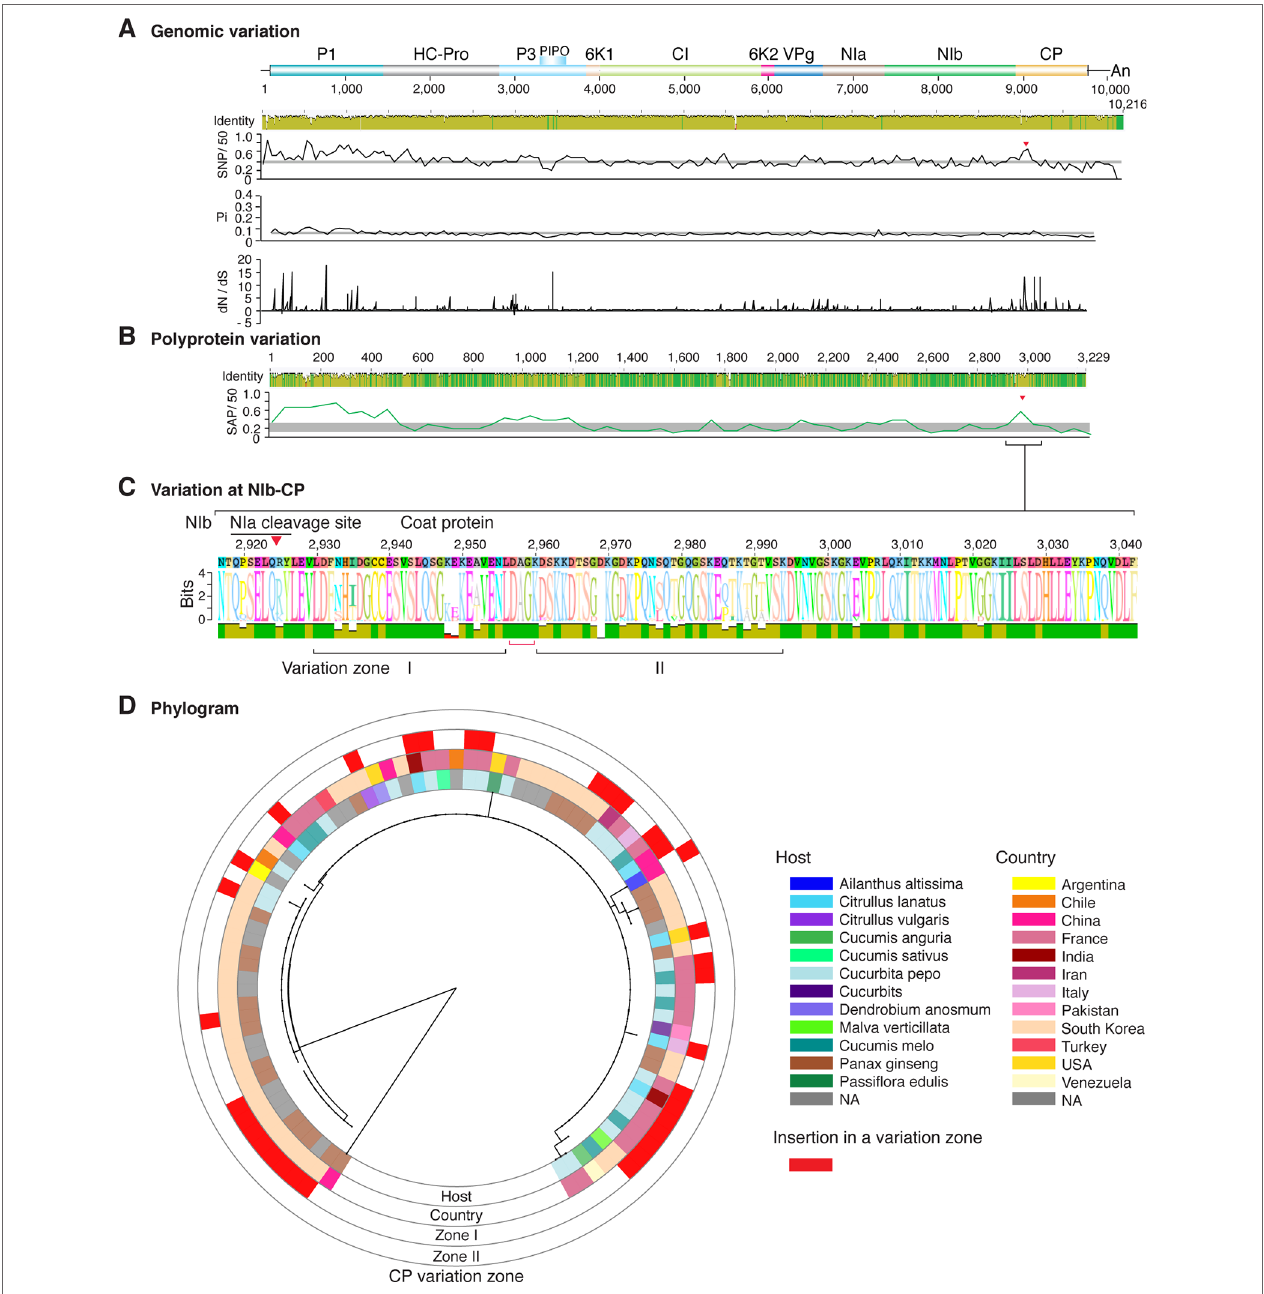
FiGUre 7 | Nucleotide and polyprotein variation in watermelon mosaic virus. Genome organization is shown to scale using accession KX926428.1 as reference. Labels are as in Figure 2 .